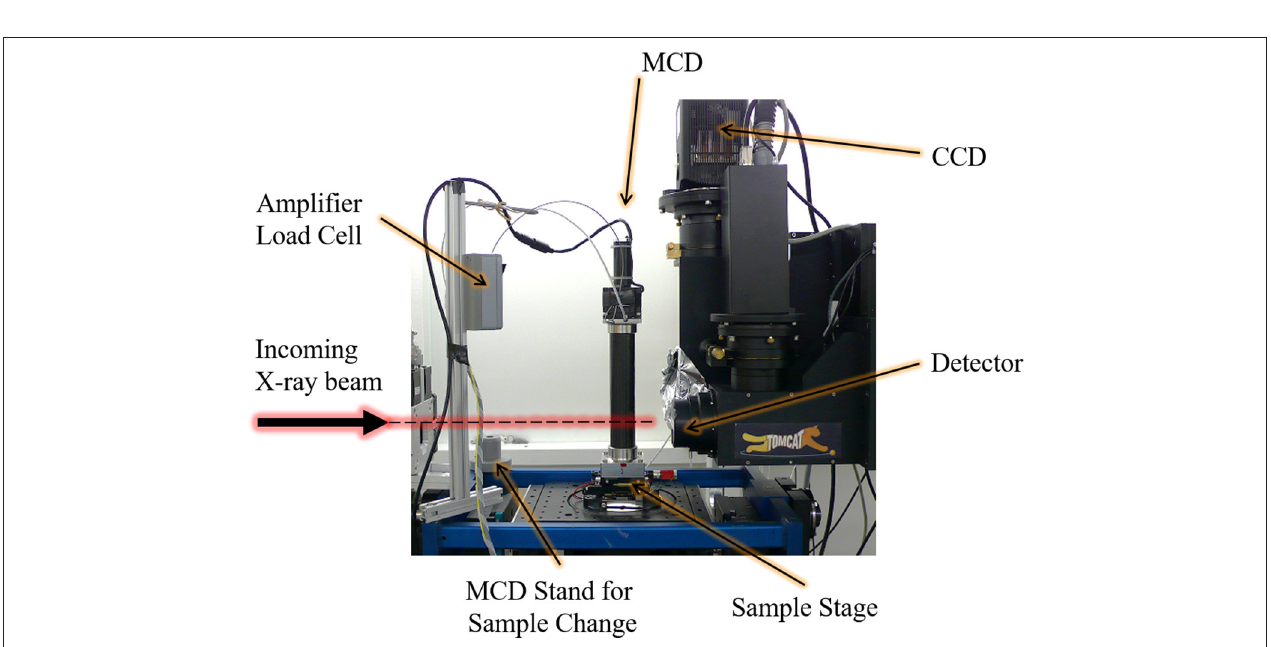
FIGURE 2 | Micro-compression device (MCD) for dynamic image-guided failure assessment (DIGFA) mounted at the TOMCAT beamline of the Swiss Light Source